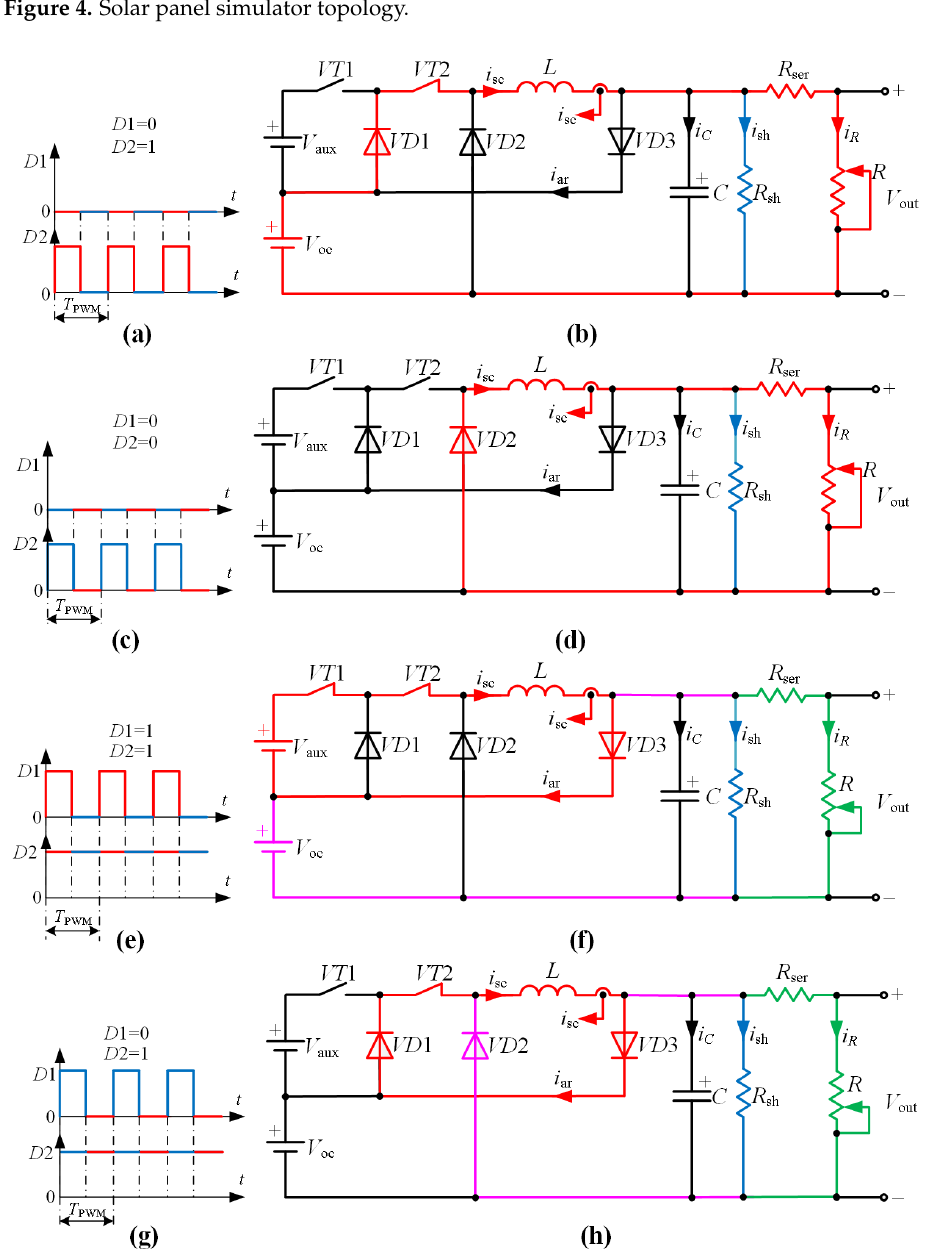
Figure 5. States of the buck converter switches ( a , c , e , g ) and corresponding states of the cir- cuit ( b , d , f , h